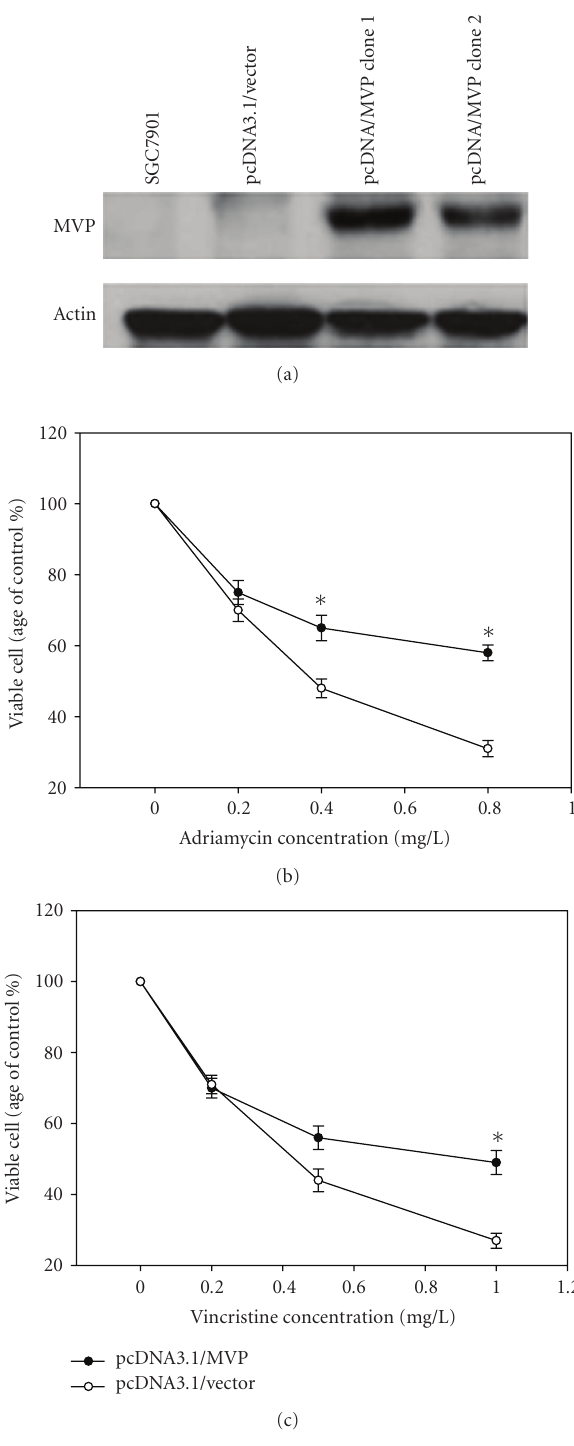
Figure 4: The e ff ect of enforced expression of MVP on drug resistance in SGC7901 cells. (a) Western blot analysis showed that two stable clones with overexpression of ectopic MVP were generated. Subsequently, MTT assay showed that overexpression of ectopic MVP could result in vincristine and adriamycin resistance, with the significant increase of the cell viability (b). The experiment was repeated in triplicate. Points: mean viable cells (% of control) from three experiments; bars: SE ∗ : P ≤ . 05 di ff er from control by t